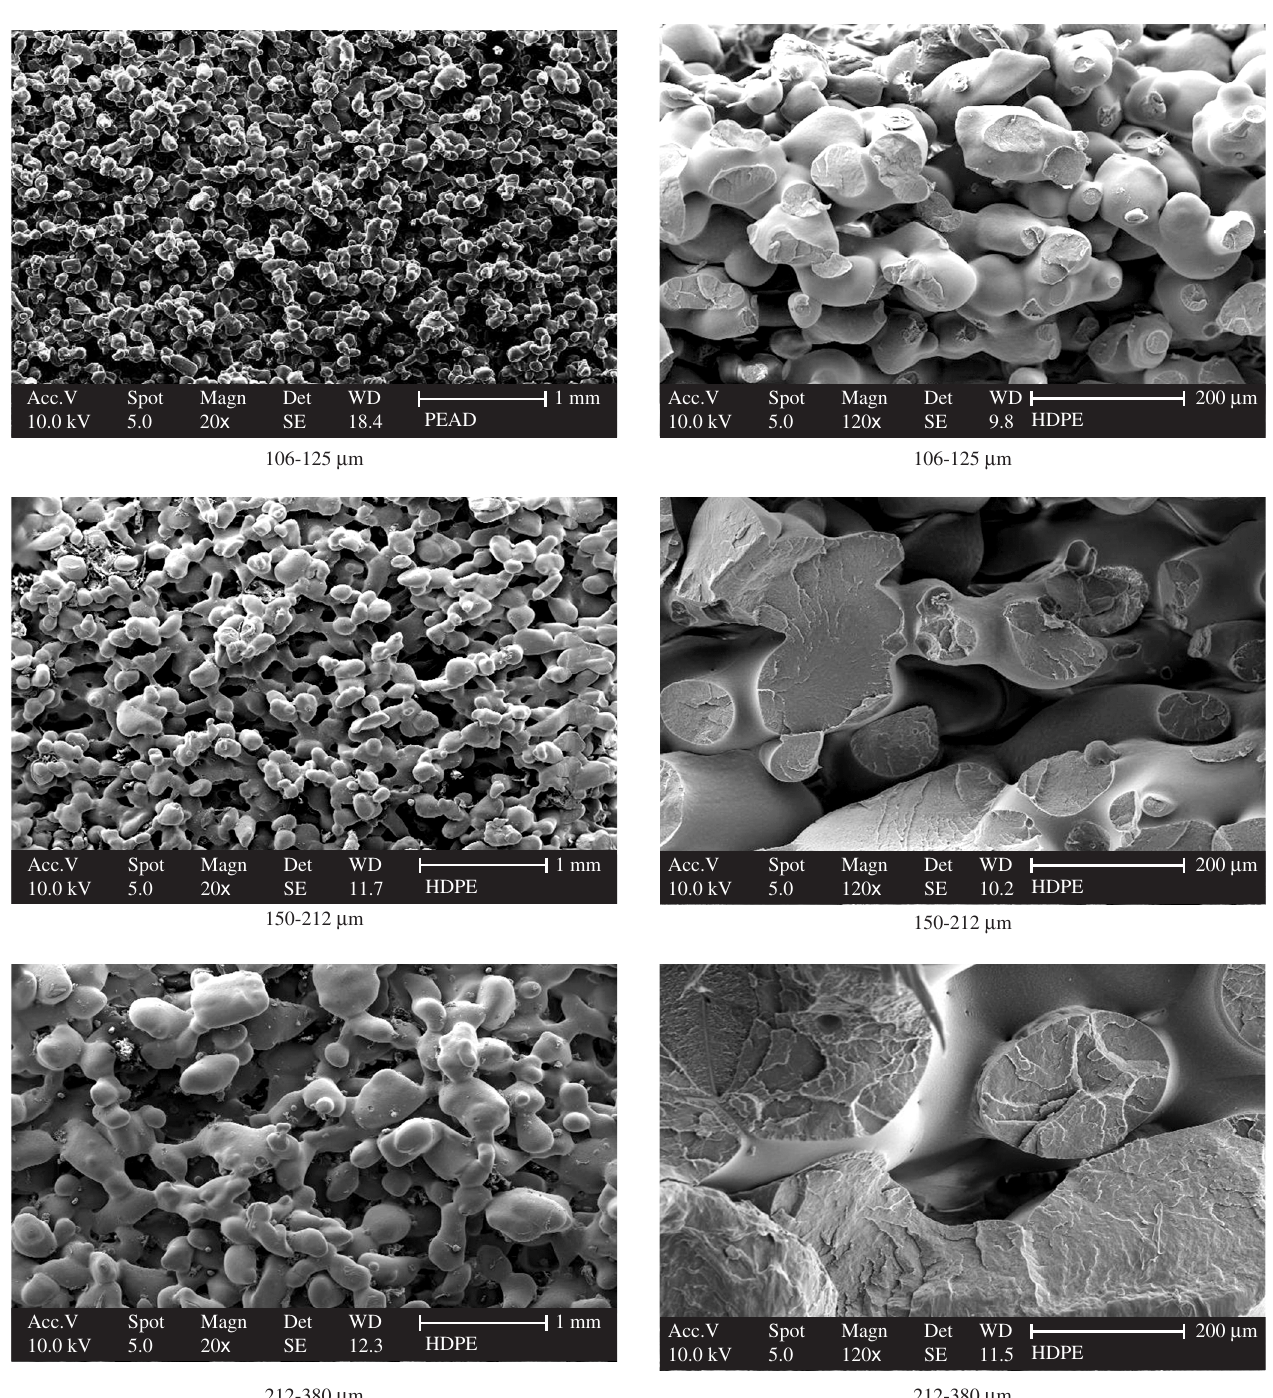
Figure 1. Micrographs of HDPE specimens surface (left) and its cryogenic fracture